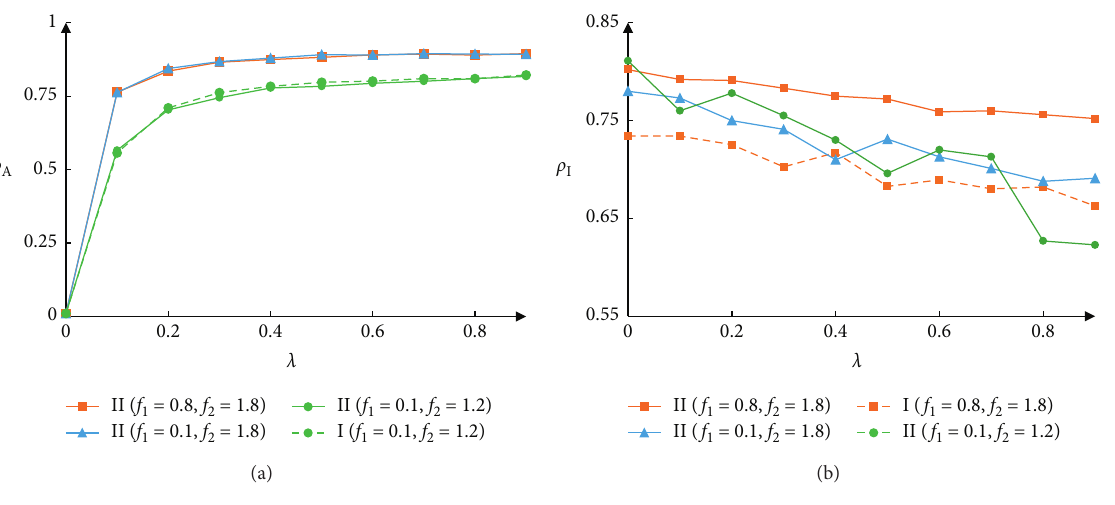
Figure 10: The influence of β on ρ